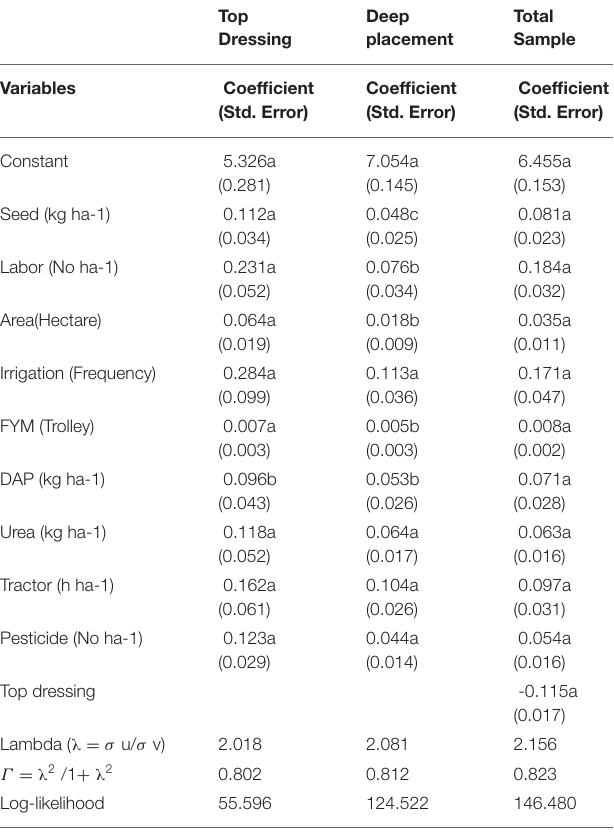
TABLE 7 | Maximum likelihood